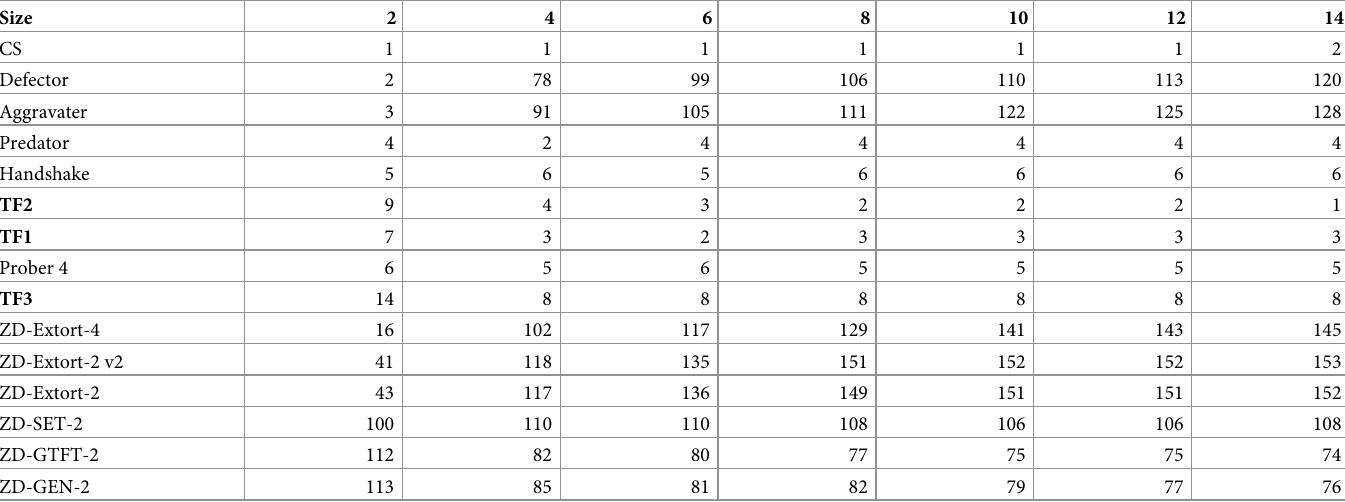
Table 13. Ranks of a few selected strategies according to x N /2 for different population sizes.